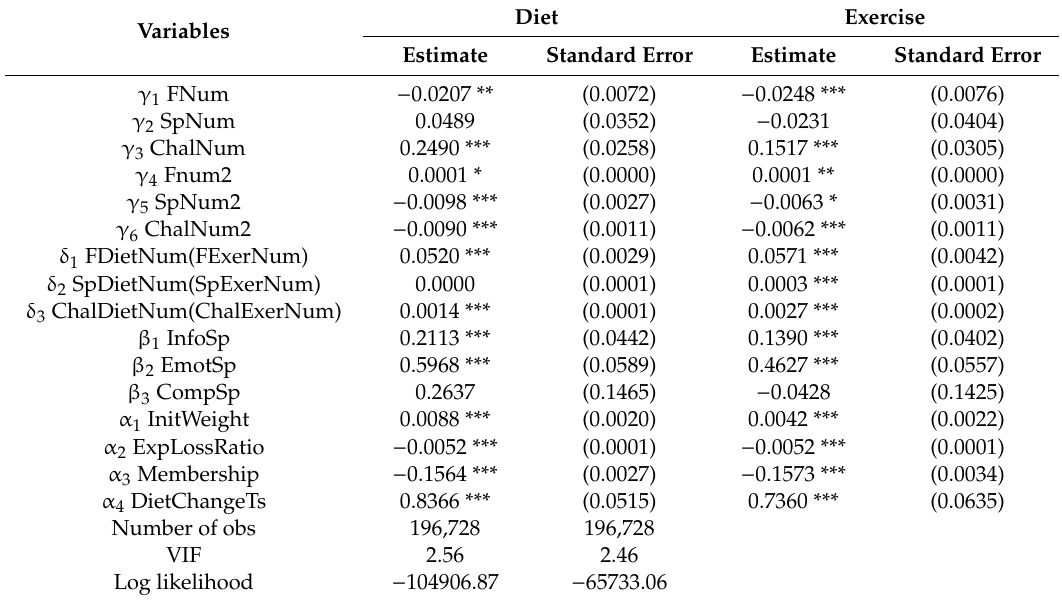
Table 3. Estimation